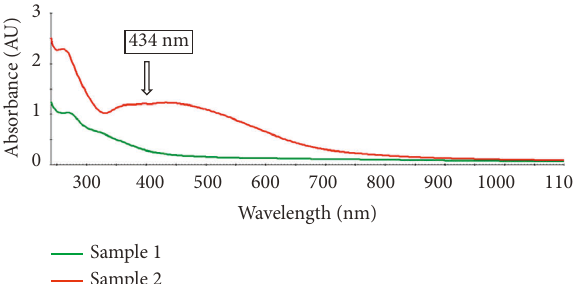
Figure 1: The color changing of Moringa oleifera leaves extracts from yellow to dark reddish brown. (a) Leaves extract solution. (b) AgNO only. (c) Leaves extract after reaction with 1 mM AgNO 3 solution at 25 ° C for 5 days.